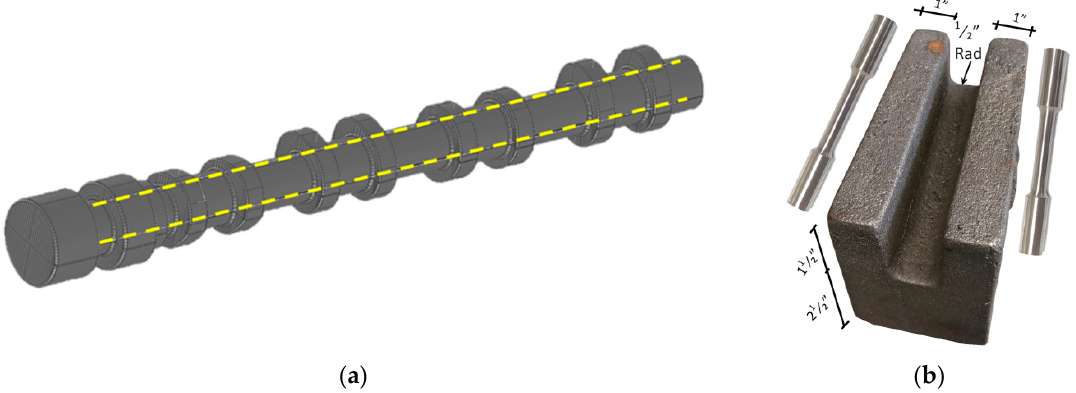
Figure 4. Samples obtained for mechanical tests from the ( a ) camshaft and ( b ) keel block